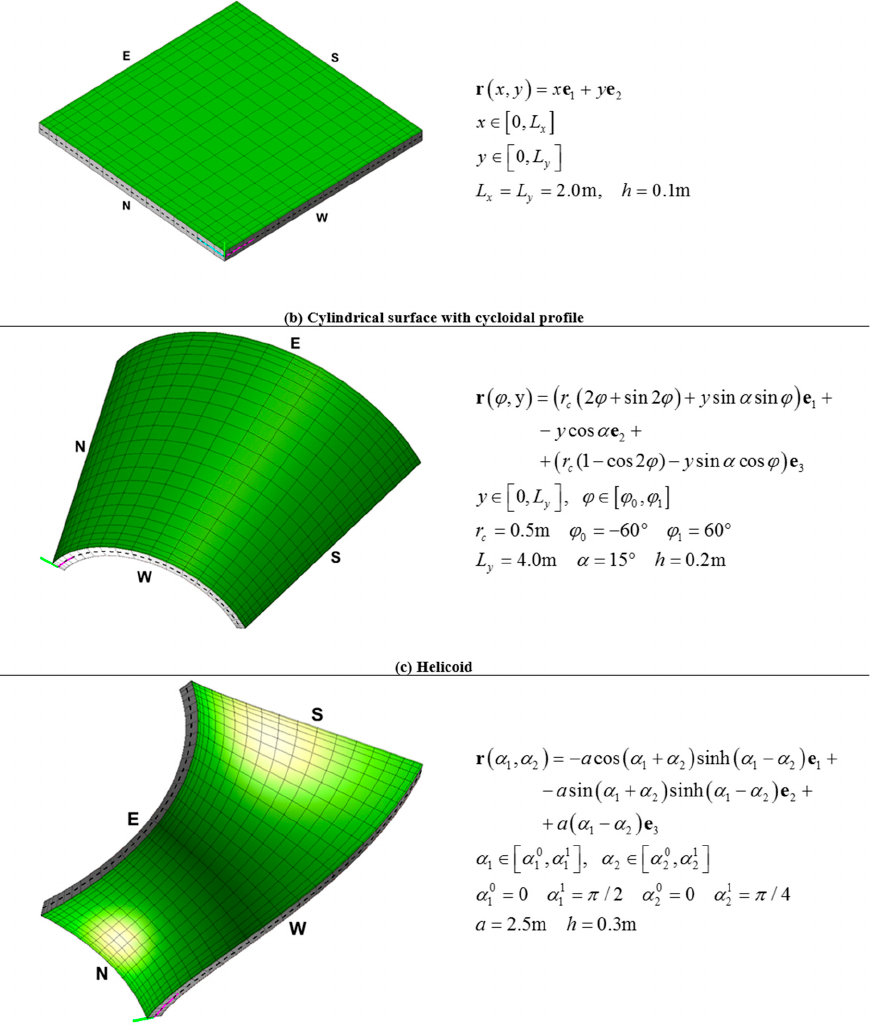
Figure 4. Three panel structures with GDQ discretization and local co-ordinate system representation. For each structure, the position vector r ( α 1 , α 2 ) is shown, along with the geometric parameters that describe the reference surface of the three structures under consideration: ( a ) rectangular plate; ( b ) cylindrical surface; ( c )